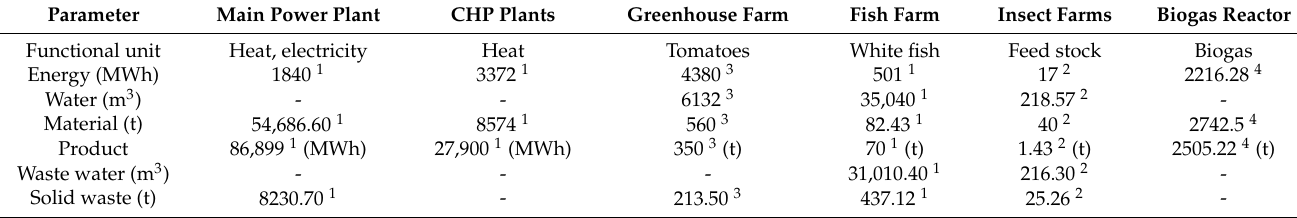
Table 1. Yearly consumption and production of businesses.